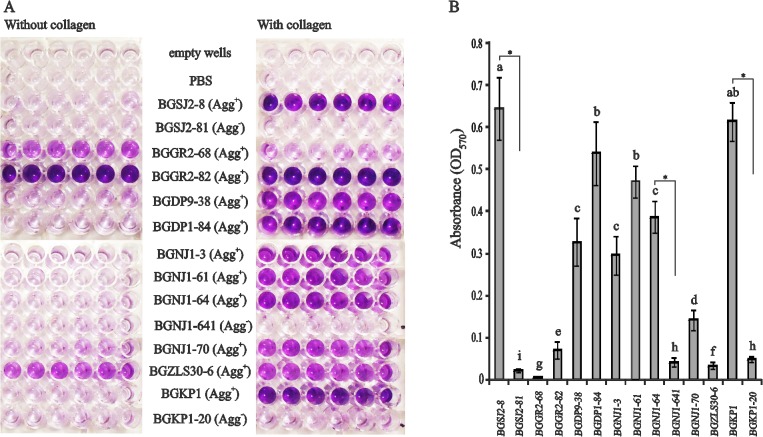
Collagen-binding assay.Binding of different Lactobacillus strains (including control strains) to immobilized collagen (A) and graphical presentation of results (B) expressed as normalized A570 values. Error bars show standard deviations. Asterisk indicates a significant difference between aggregating strains and their non-aggregating derivatives (p<0.001). Within columns, values with different superior letters differ significantly (P<0.05).